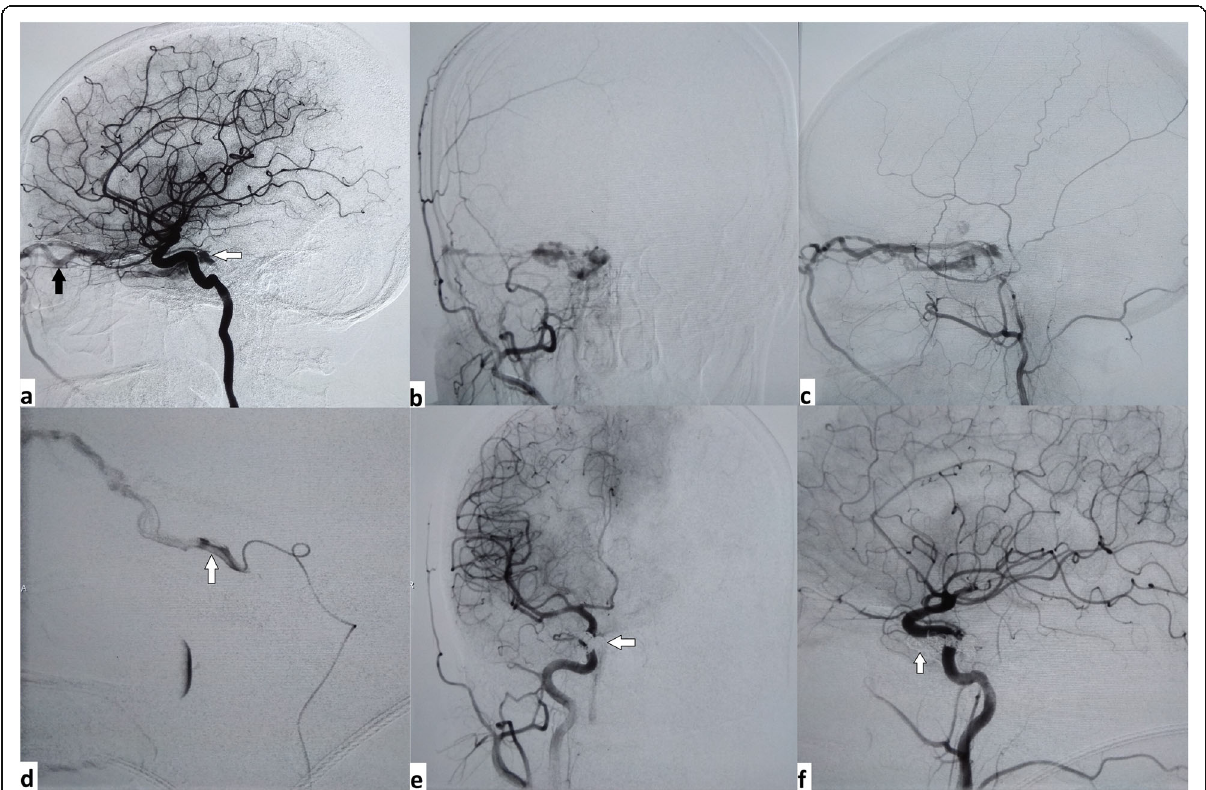
Fig. 4 a Right ICA DSA image shows opacification of right cavernous sinus (white arrow) and SOV (black arrow) in arterial phase. Right ECA DSA in AP ( b ) and lateral ( c ) projections show type D indirect CCF with retrograde contrast flow in right SOV. d DSA image showing super-selective cannulation of right cavernous sinus via right inferior petrosal sinus with tip of the microcatheter in distal right SOV (arrow). Post coiling DSA in AP ( e ) and lateral ( f ) projections show complete occlusion of the CCF with coil mass in right cavernous sinus and adjacent segment of right SOV